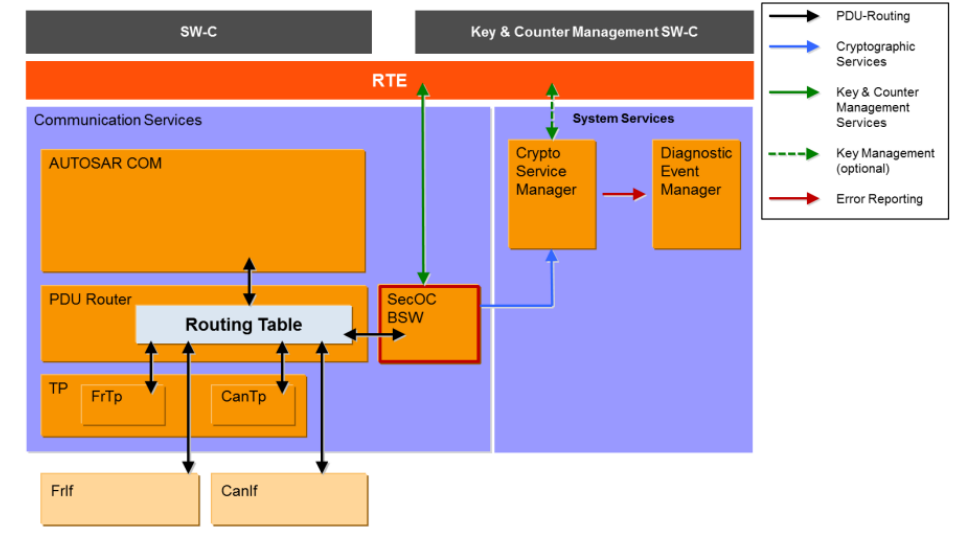
Figure 20. Integration of SecOC.